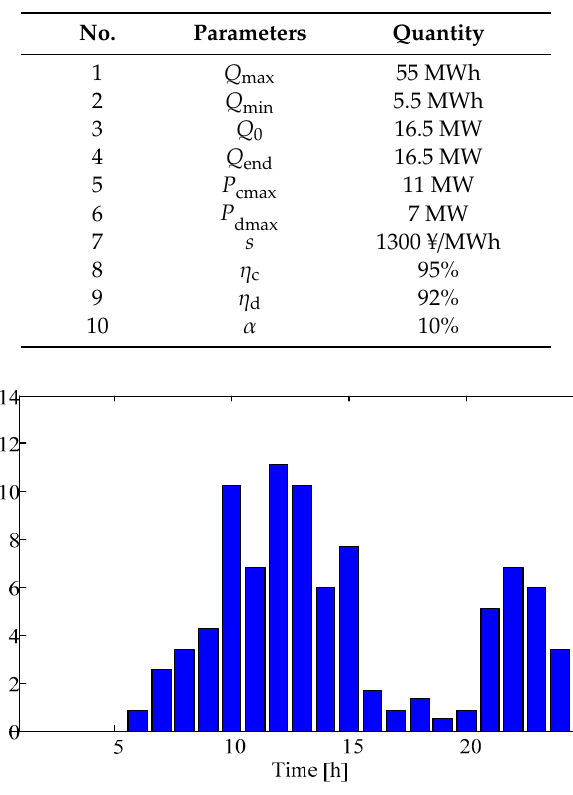
Table 1. Parameters of the BSS.